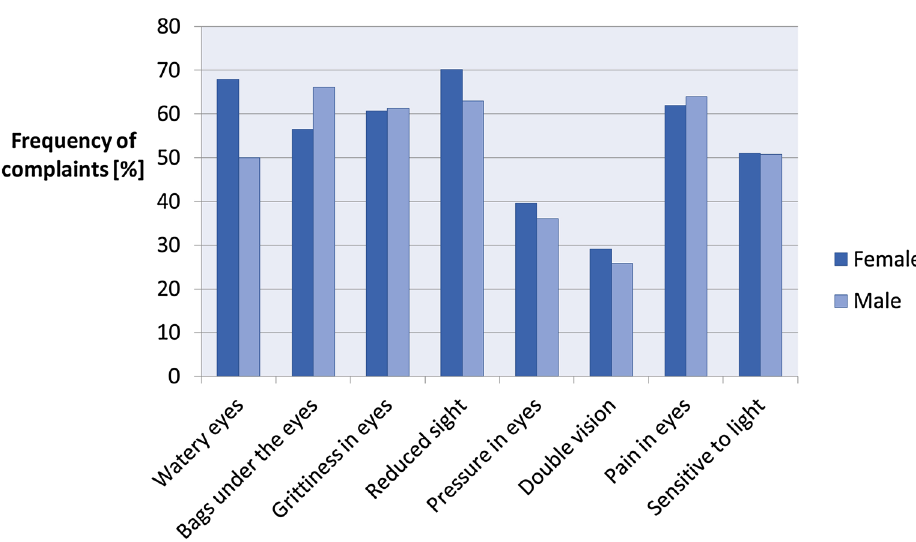
Figure 1. The prevalence of eye symptoms in patients with thyroid diseases based on the results of ThyPROpl questionnaire among women and